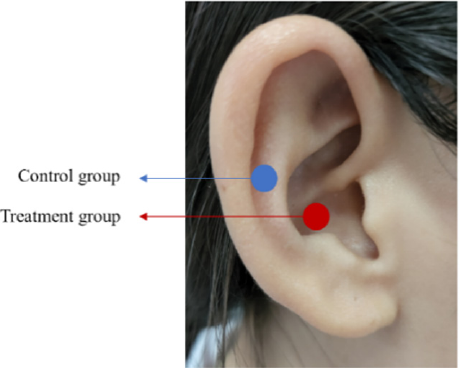
Figure 2. Positioning of the electrode of the t-VNS device for stimulation in the treatment and control